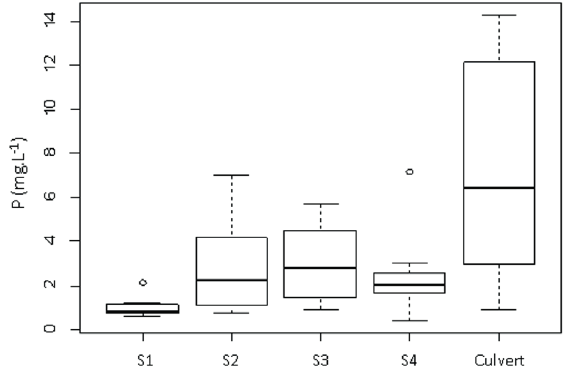
Figure 4 - P concentrations obtained at different locations, including the four cross-sections S1 – S4 and a culvert located between S1 and S2.